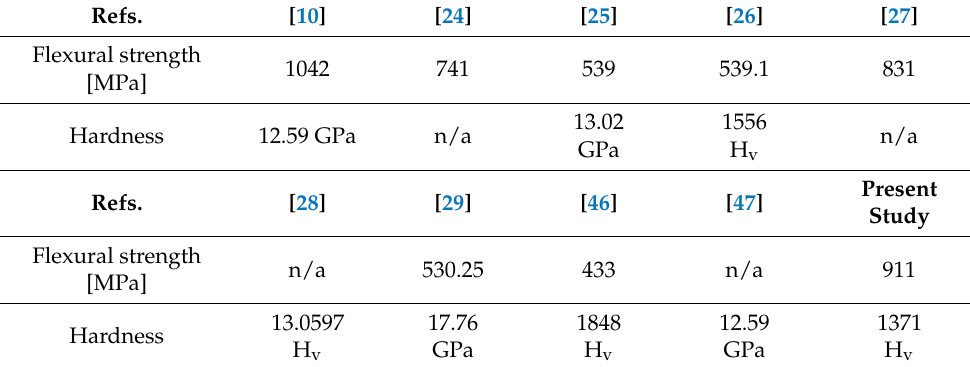
Table 4. A brief review on mechanical properties of zirconia components manufactured by DLP process.